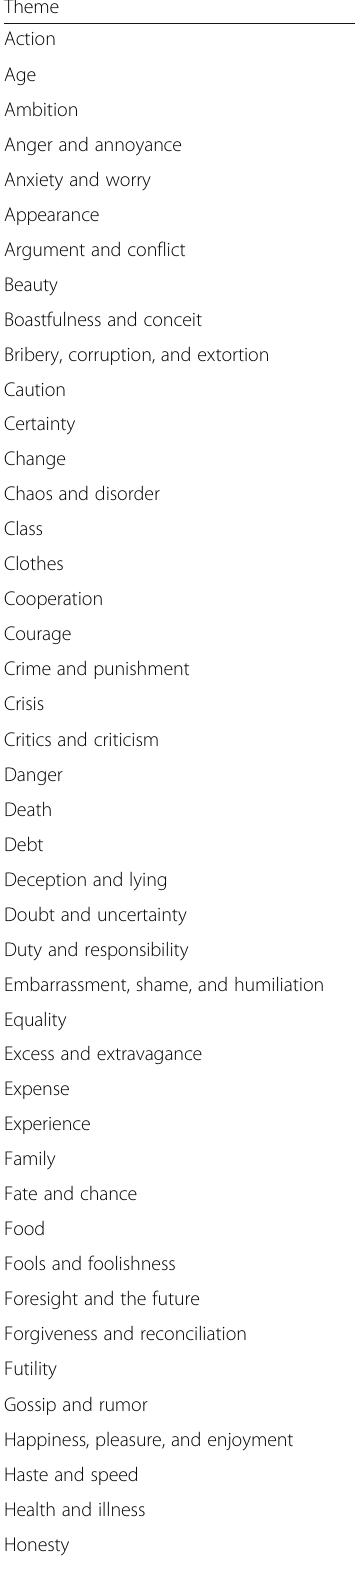
Table 2 Themes of Oxford Dictionary of Idioms